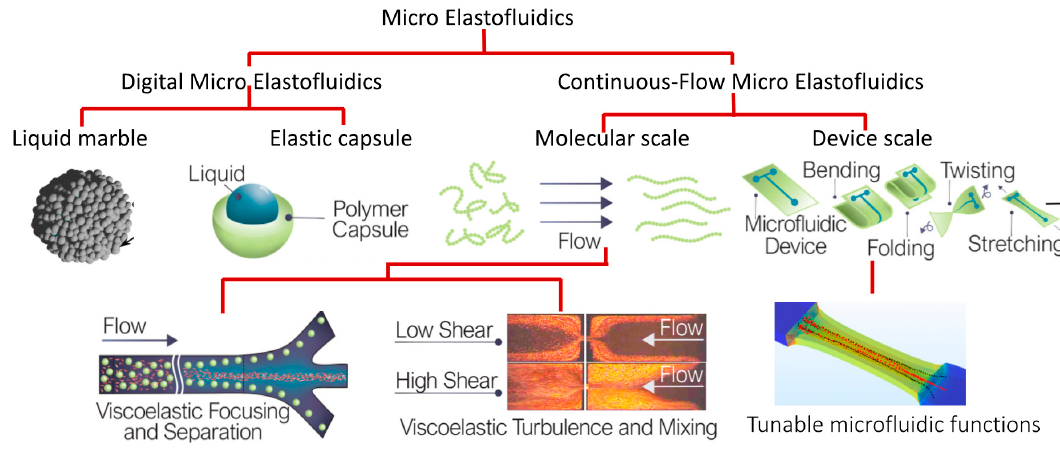
Figure 1. Micro elastofluidics with its possible platforms and